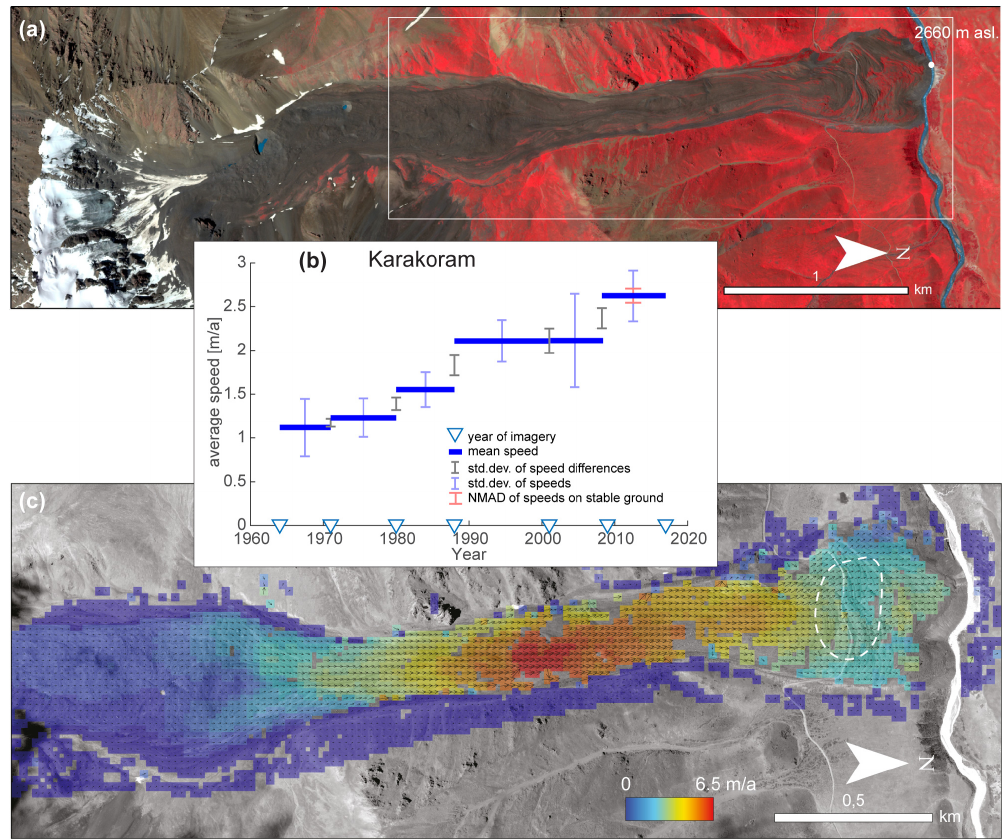
Figure 5. Velocities and speed variations on the Karakoram rock glacier. (a) Overview image; © Planet image on 7 September 2016 in near-infrared false colour. (b) Average time series of speeds for a cluster of points (white dashed outline in panel c ). Error bars give standard deviations of speeds within the point cluster (blue), standard deviations of speed differences within the measurement periods (grey), and the NMAD of stable ground offsets (red, 2009–2017 only) in m/a. Blue triangles on the time axis indicate years of imagery used. (c) Colour- coded velocity field with vectors superimposed from image matching between 2009 and 2017 high-resolution satellite images (for exact dates and sensors see Table S2). Background image: GeoEye, 29 July 2017, ©